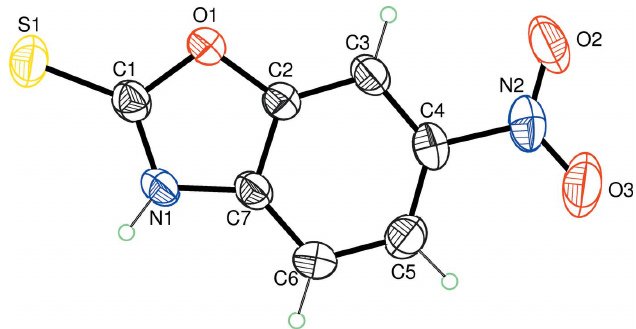
Figure 1 The molecular structure of the title compound with displacement ellipsoids drawn at the 50% probability level.